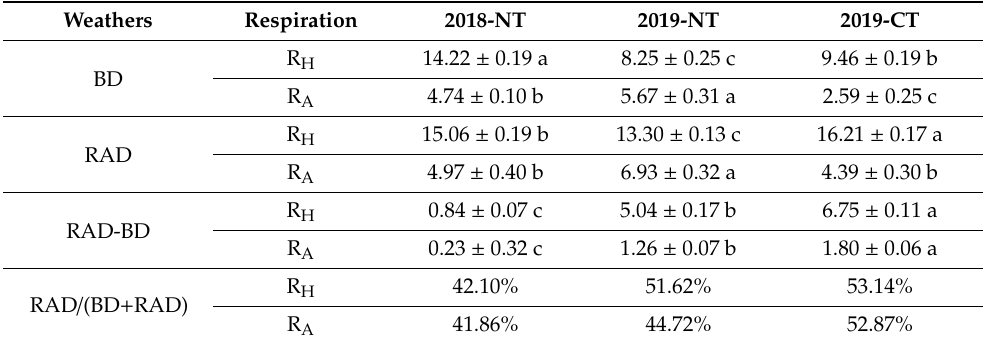
Figure 2. Daily soil heterotrophic respiration (R H ) ( A ) and autotrophic respiration (R A ) ( B ) in response to tillage practices during maize growth stages in 2018 and 2019. Table 1. Mean ( ± SE) daily R H and R A (g CO 2 m − 2 d − 1 ) on BD and RAD in response to tillage practices during maize growth stages in 2018 and 2019.